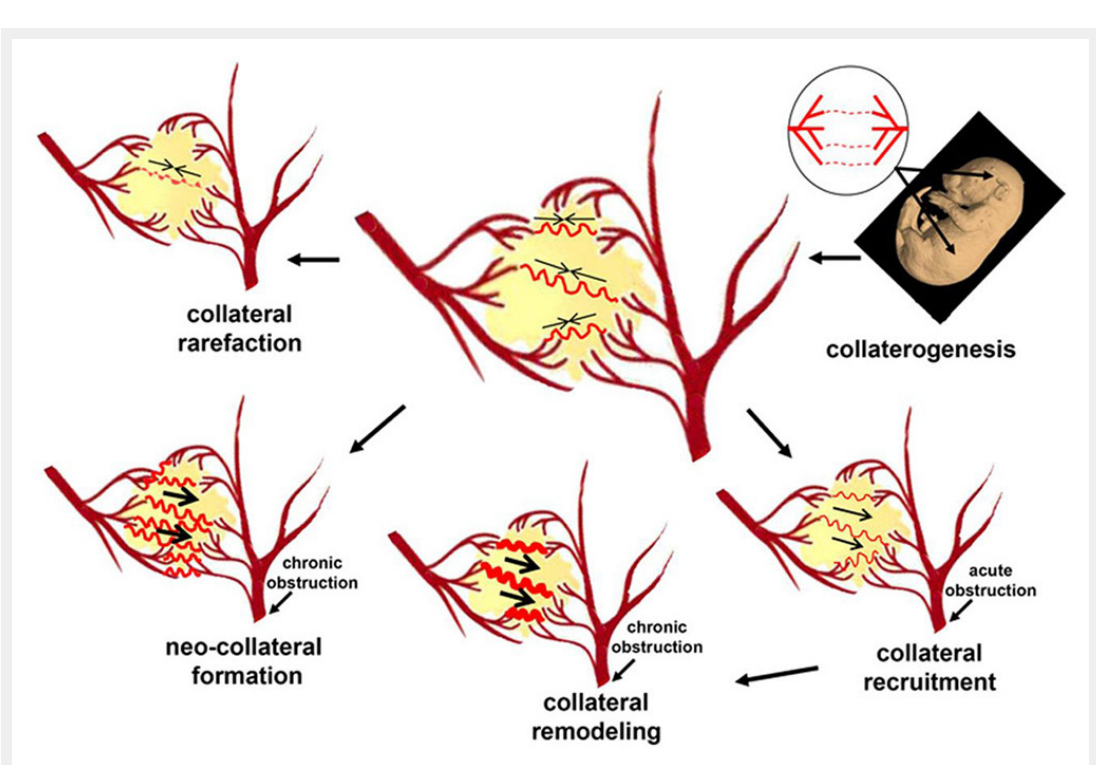
Lifecycle of the collateral circulation. The native collateral extent in the adult is determined by its formation in embryonic collaterogenesis (top right). Blood moves to and fro in native collaterals, while effective flow is recruited by acute obstruction. With continued obstruction, there is collateral enlargement, which occurs independent of ischaemia. Neocollateral formation has been suggested in chronic obstructive disease, whereas experimental studies have shown collateral rarefaction with aging. (Data from Faber JE, et al. A brief etymology of the collateral circulation. Arterioscler Thromb Vasc Biol. 2014;34:1854–9 [1], with